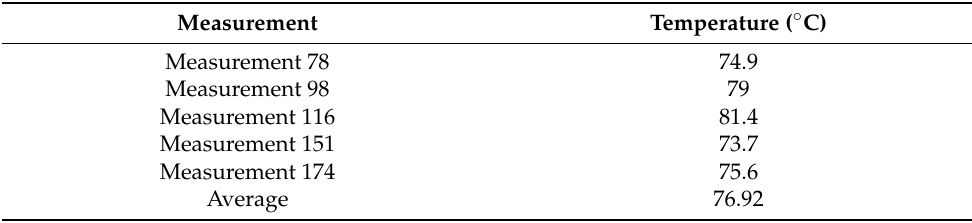
Figure 11. Temperature profile measured by a thermocouple during the experimental injection process. Table 10. Experimental temperature measurements in the area of contact between the cavity and the